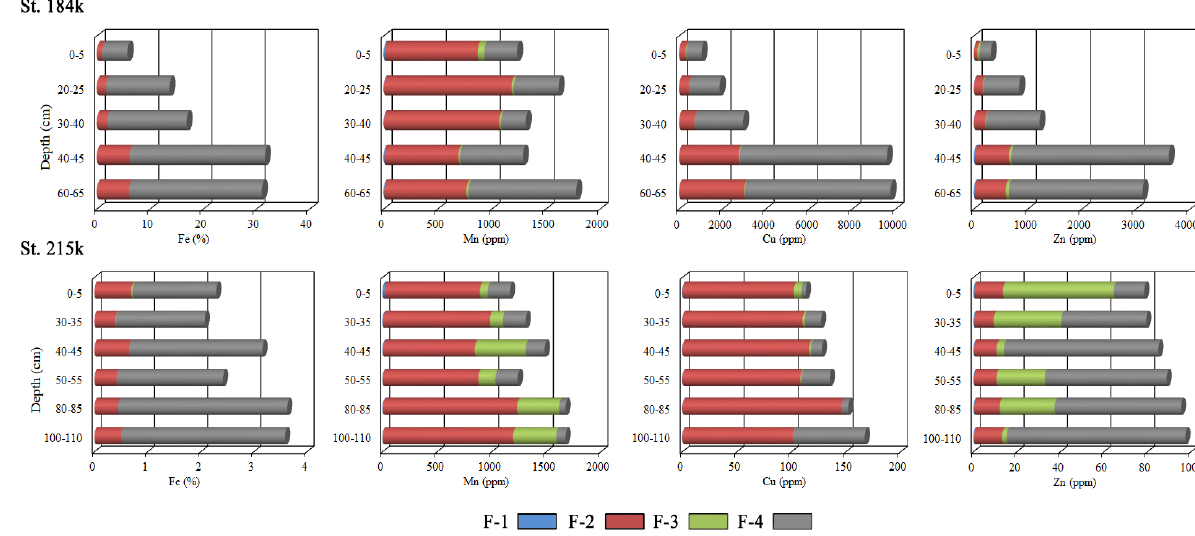
Figure 5. Geochemical fractions of metals in the metalliferous (St.184k) and background (St. 215k) cores. Fractions: F-1, exchangeable elements adsorbed mainly onto the clay and carbonate particles; F-2, authigenic Fe-Mn hydroxides and related trace elements; F-3, bound to organic matter or sulfides; F-4, refractory, metals fixed in crystalline lattices of mineral particles.